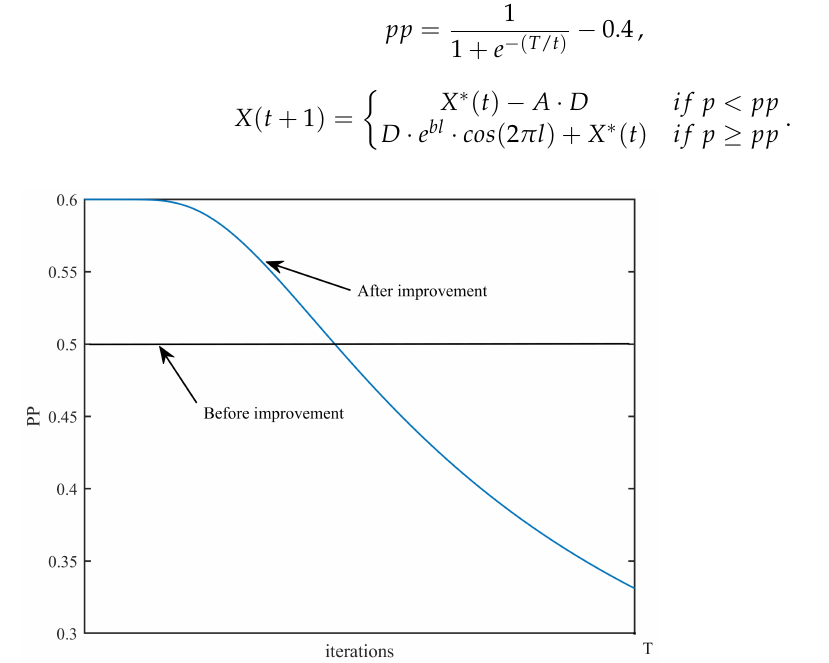
Figure 3. Trend of pp changes with iteration times before and after